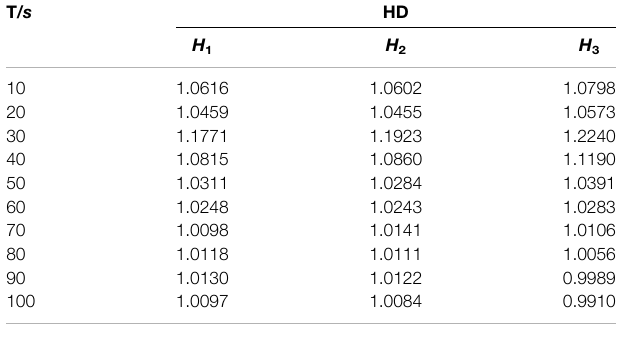
TABLE 8 | Healthy degree of engine equipment from normal operation to fault 3.